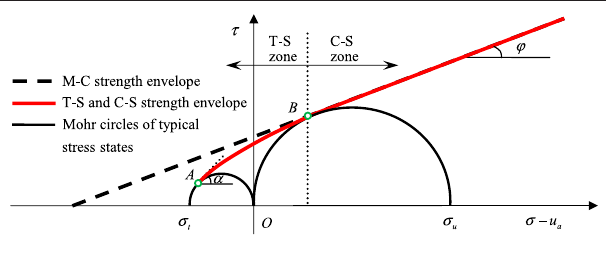
FIGURE 5 | Failure envelopes of unsaturated clay under tension-shear and compression-shear stresses (note: the T-S zone and C-S zone mean the compression-shear action zone and tension-shear coupling action zone,